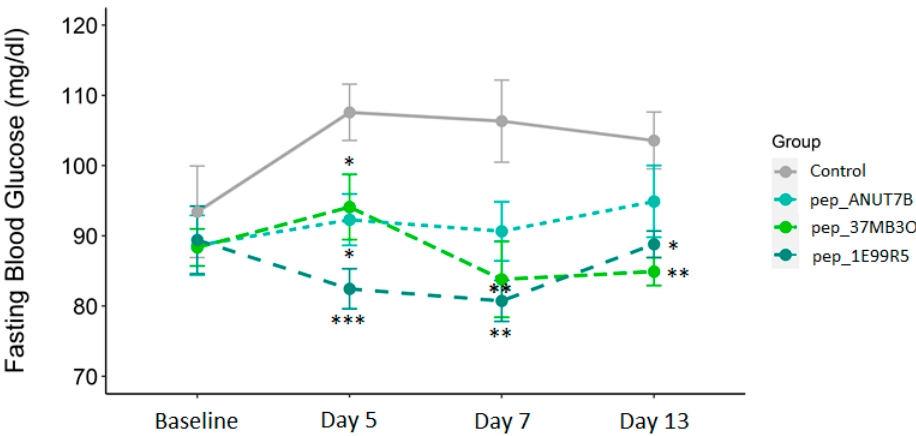
Figure 3. Predicted peptides in a mouse model of type 2 diabetes. Fasting glucose levels (overnight) of all mice were measured as indicated. Data are mean ± SEM ( n = 8 per group; aged 12 weeks at baseline) and analysed by Dunnett’s test to compare the differences between the peptide treatment groups and the vehicle control group (* p < 0.05 ** p < 0.01 *** p <